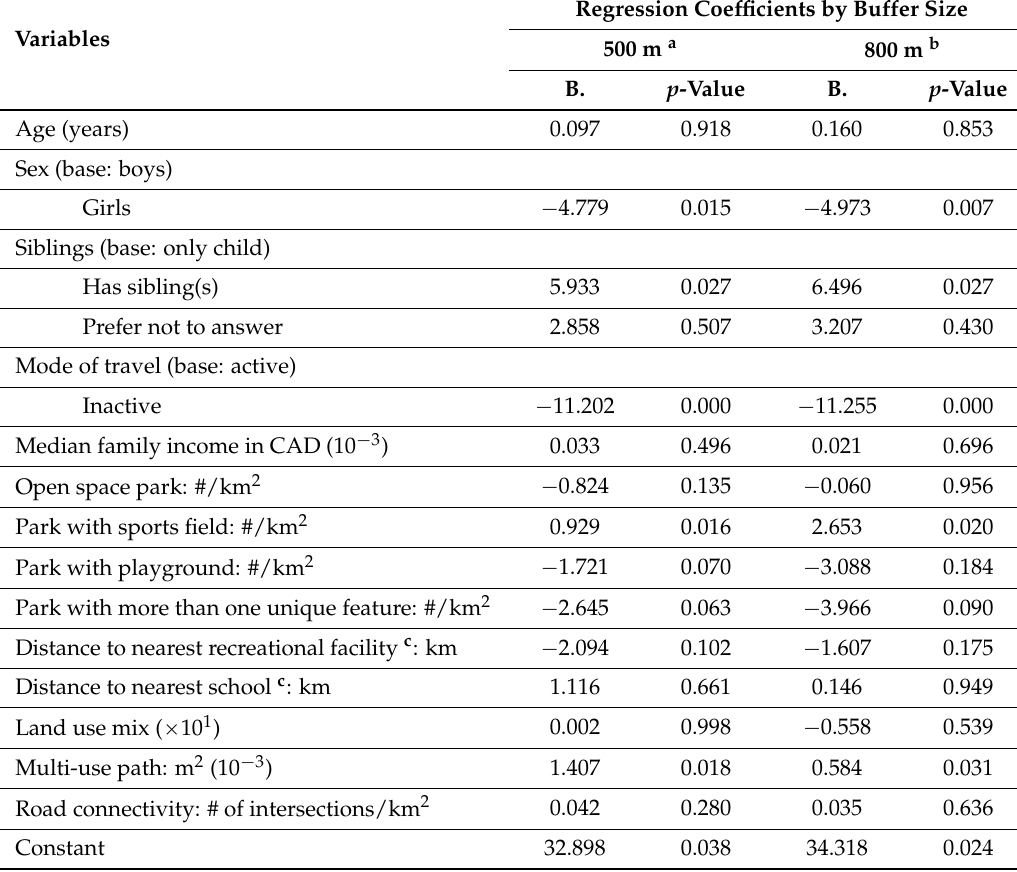
Table 4. Results of full model assessing associations between environment characteristics by buffer size and average daily minutes of MVPA outside of school hours during weekdays ( n =